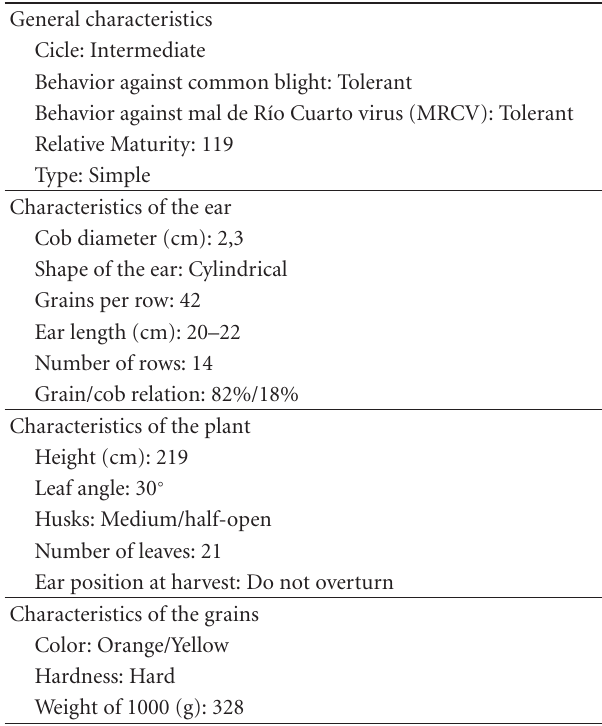
Table 1: Characteristics of DK684RR2 maize